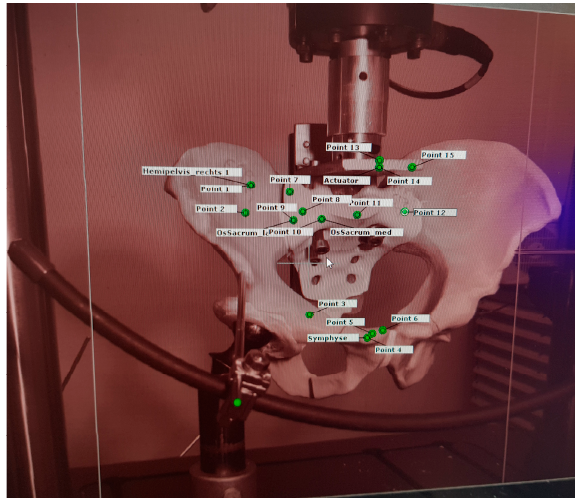
Figure A4. Interfragmentary displacements were continuously measured in all six degrees of freedom using two optical cameras at a rate of 50 Hz.